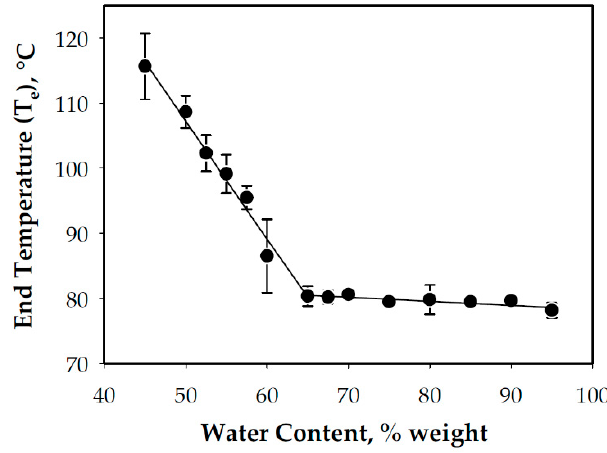
Figure 5. The gelatinization completion temperature as a function of the water content in a wet basis.